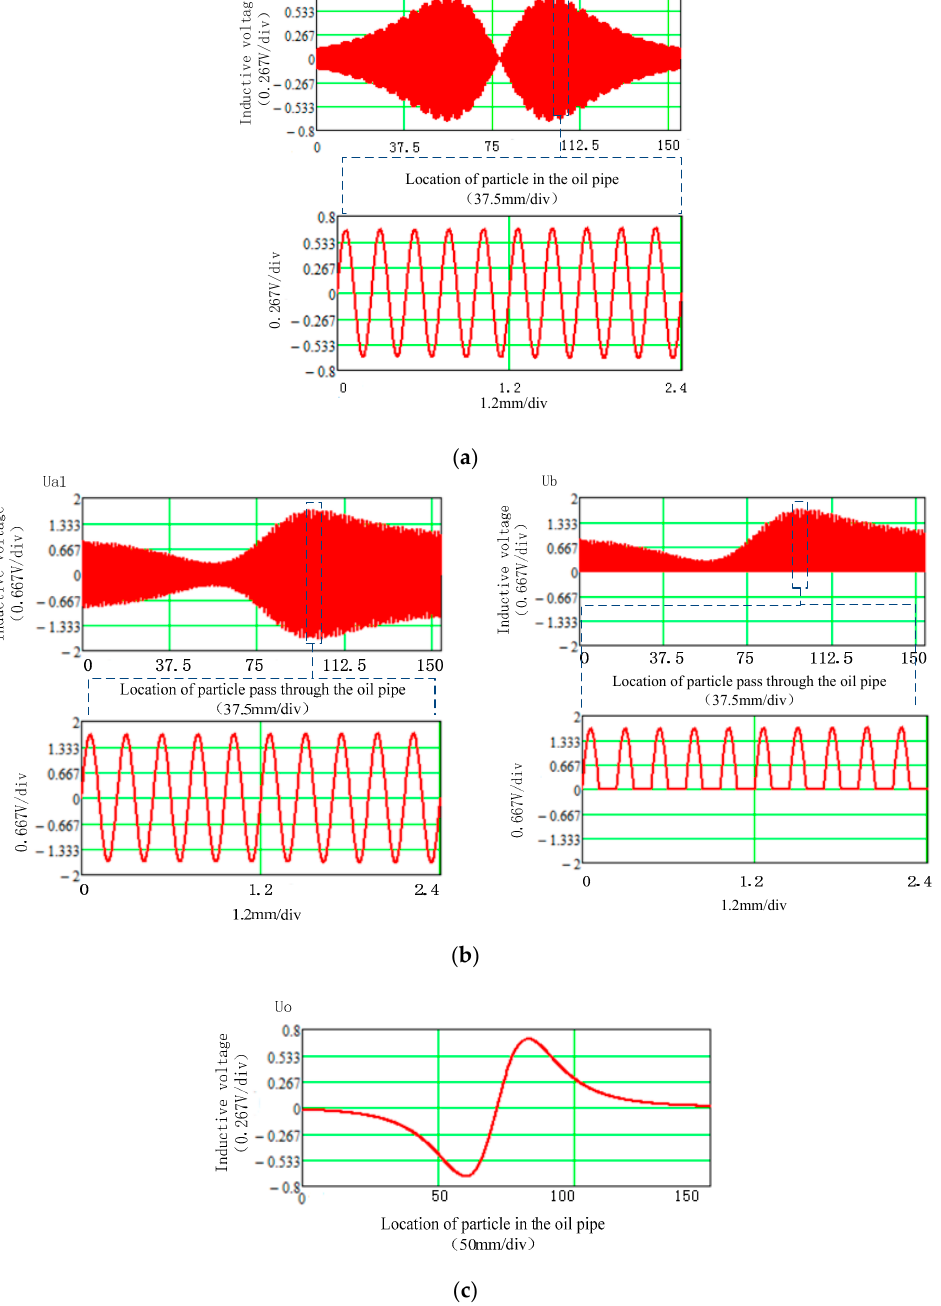
Figure 10. Voltage waveforms of Ua, Ua1, Ub, and Uo. ( a ) Voltage waveform of Ua and local amplification waveform. ( b ) Voltage waveform of Ua1, Ub and local zoom in waveform. ( c ) Voltage waveform of